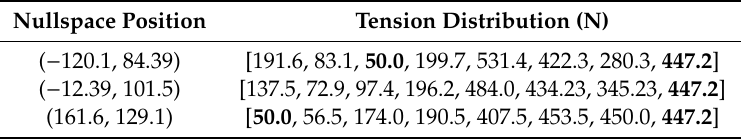
Table 2. Tension distribution for each nullspace position ( δ 8 = 0.447 m ) .